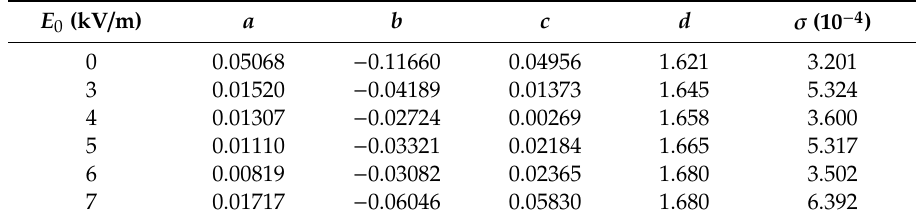
n of E7 in the frequency range of 0.4–1.4 THz. The different Figure 4. E ff ective refractive index n ef f of E7 in the frequency range of 0.4–1.4 THz. The di ff erent lines Figure 4. Effective refractive index eff depict the fitting results of the experimental data [40]. lines depict the fitting results of the experimental data [40]. Table 1. Optimal coe ffi cients and the root-mean-square error of the cubic polynomial fit for the e ff ective Table 1. Optimal coefficients and the root-mean-square error of the cubic polynomial fit for the refractive effective refractive index.